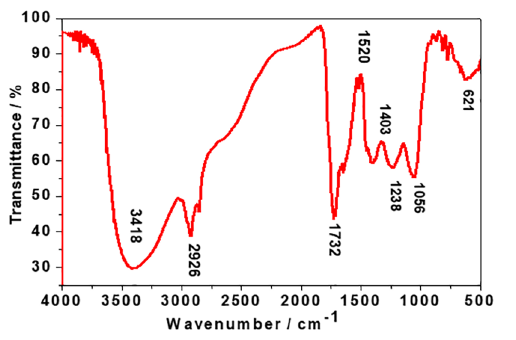
Figure 1. FTIR spectrum of the cocoa bark extract.